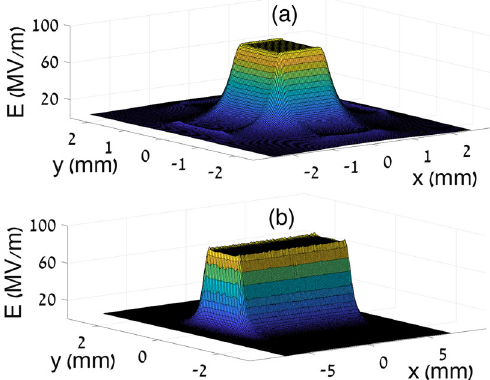
FIG. 4. Example oscilloscope trace of a subcritical (i.e., prebreakdown) current spike, recorded at a high sample rate of 500